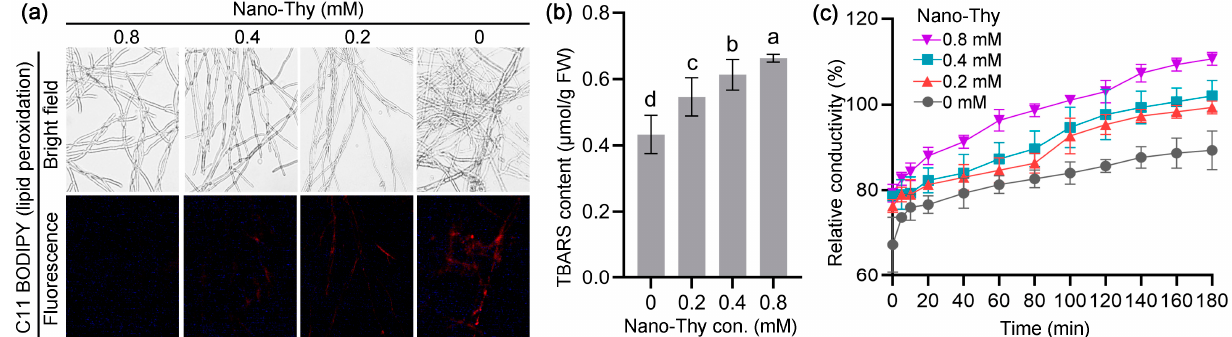
Figure 8. Effect of Nano-Thy on lipid peroxidation and relative conductivity in the mycelia of B. cinerea . ( a ) Fluorescent detection of lipid peroxidation using C11 BODIPY; different lowercase letters indicated significant difference among treatments (ANOVA, n = 3, p < 0.05); ( b ) mycelial TBARS content; ( c ) relative conductivity of mycelia.